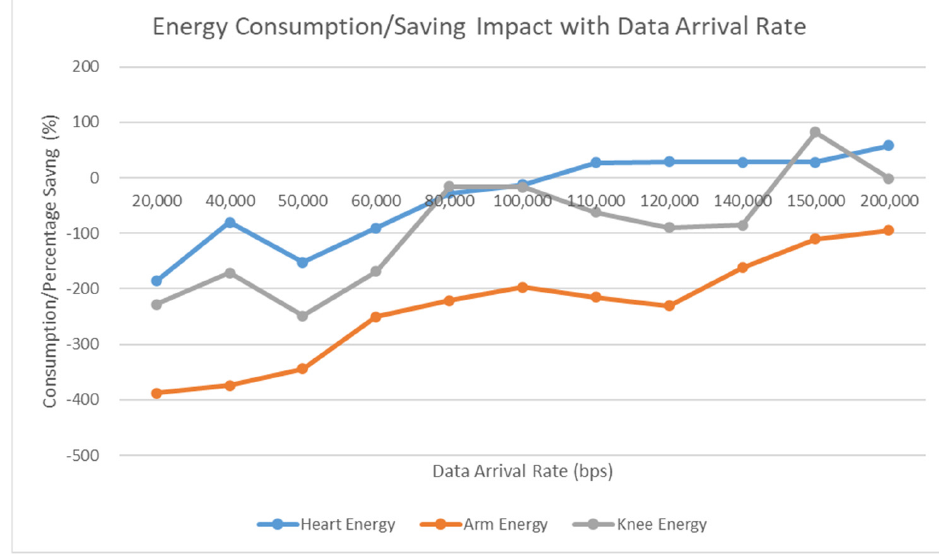
Figure 8. Energy consumption and saving with respect to varying data arrival rates.